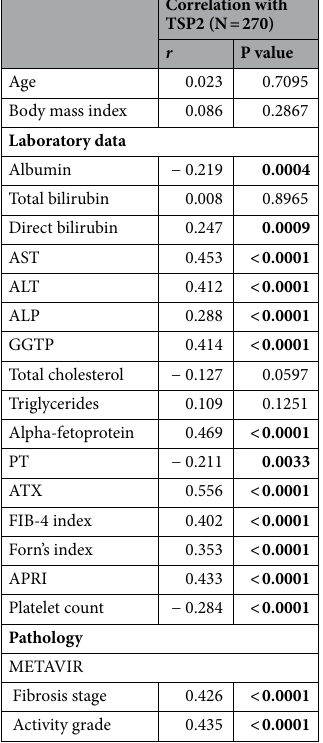
Table 2. Correlation between TSP2 and clinicopathological parameters in the discovery cohort. Significant values are in bold. Correlations were calculated using Spearman’s test. ALT alanine aminotransferase, ALP alkaline phosphatase, APRI aspartate aminotransferase to platelet ratio index, AST aspartate aminotransferase, ATX autotaxin, FIB-4 index fibrosis-4 index, GGTP gamma-glutamyl transpeptidase, PT prothrombin time, TSP2 thrombospondin